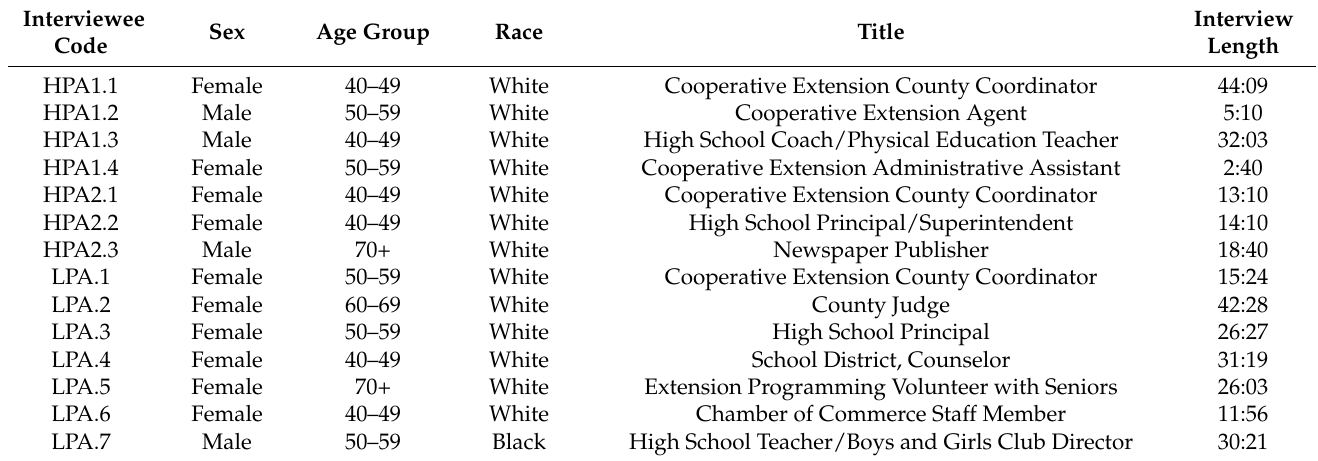
Table 2. Key stakeholder interviewee